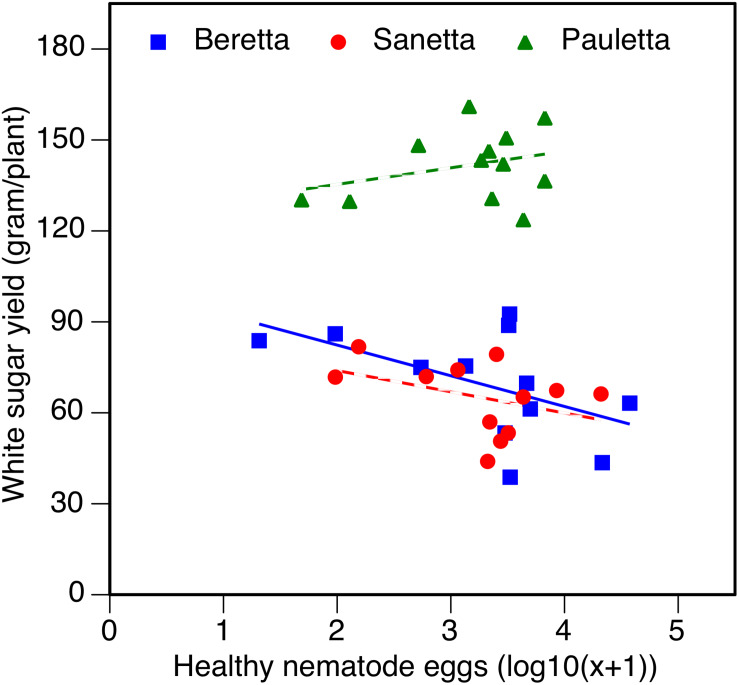
White sugar yield of sugar beet in relation to healthy nematode eggs at planting in Heterodera schachtii Schach1-infested soil at Münster in 2010–2012. Data are averaged across treatment. Beretta f(x) = –10.1271 x + 102.5928, R2 = 0.20; P = 0.0808.